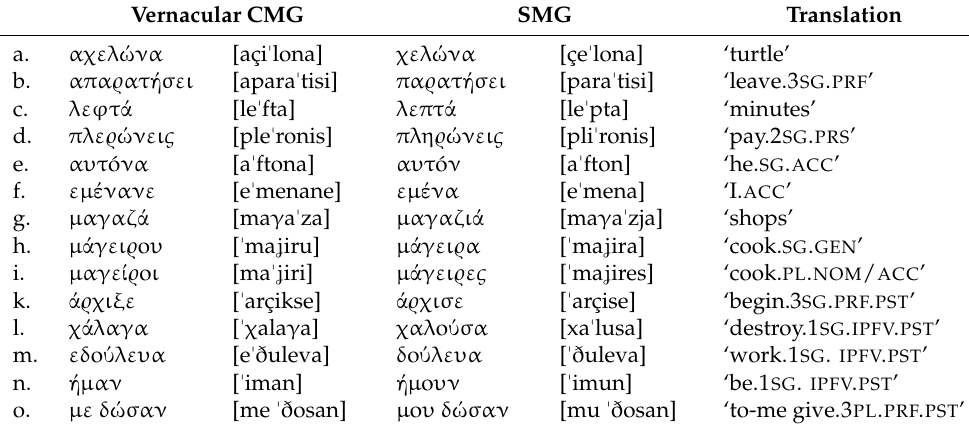
Table 3. Examples of (vernacular) CMG features in the speech of